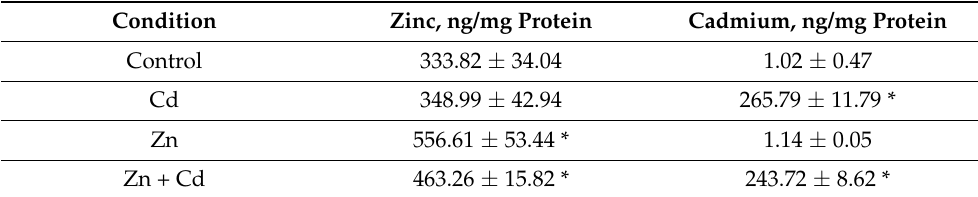
Table 1. Elemental Zinc and elemental cadmium accumulation in choroid plexus epithelial cells (CPECs) exposed for 12 h to 500 nM CdCl 2 and supplemented with Zinc.